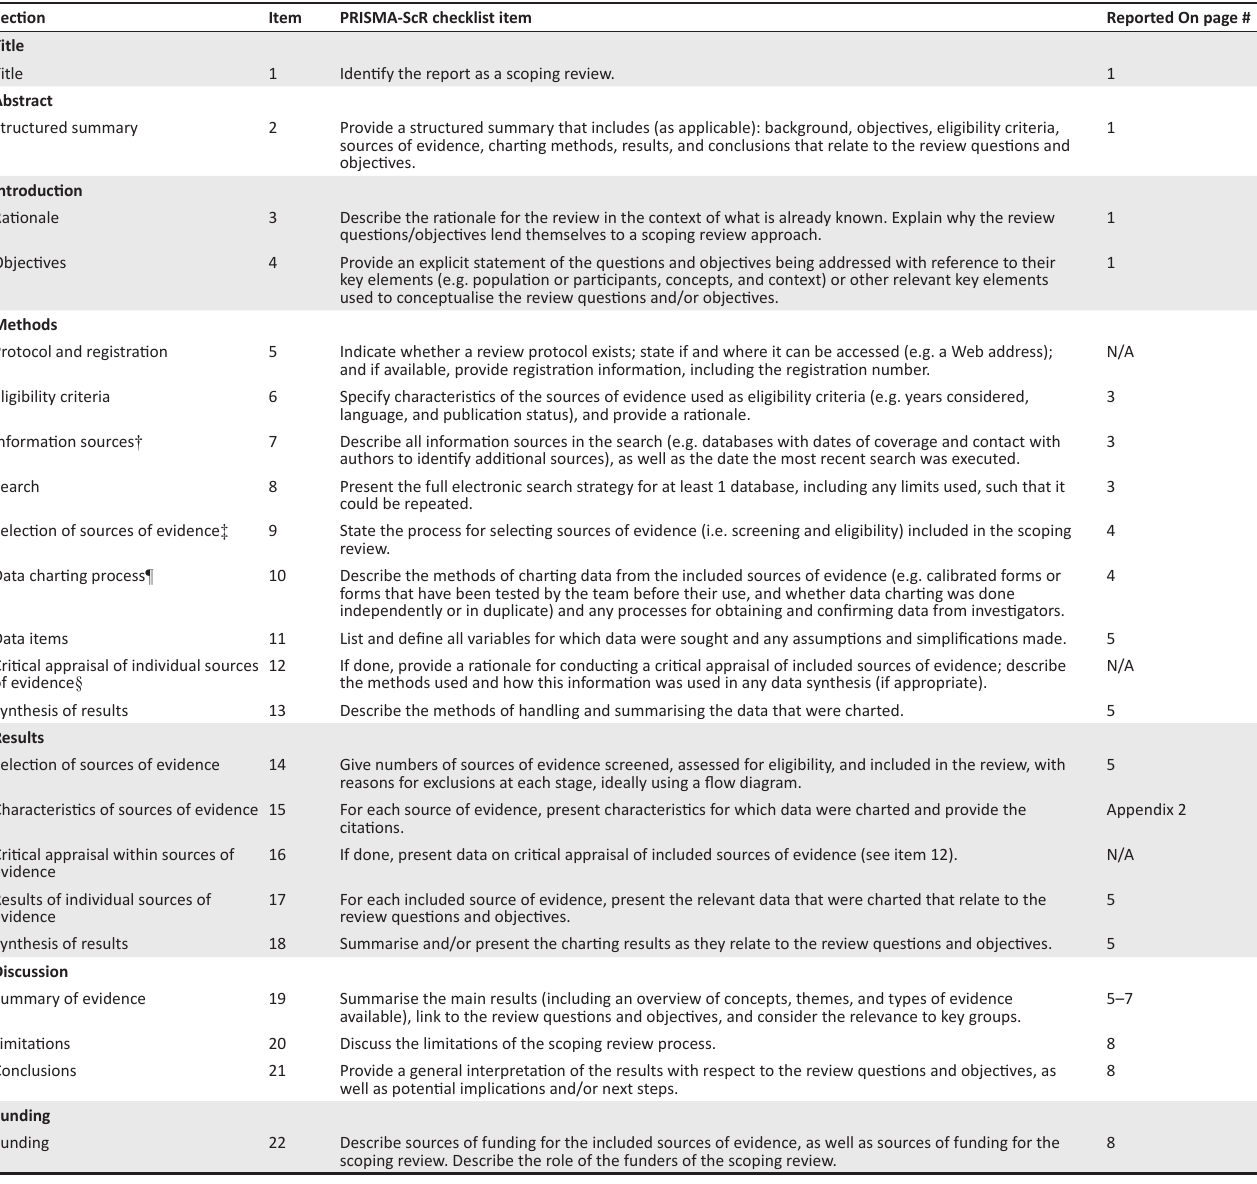
TABLE 1-A1: Preferred Reporting Items for Systematic reviews and Meta-Analyses extension for Scoping Reviews (PRISMA-ScR)